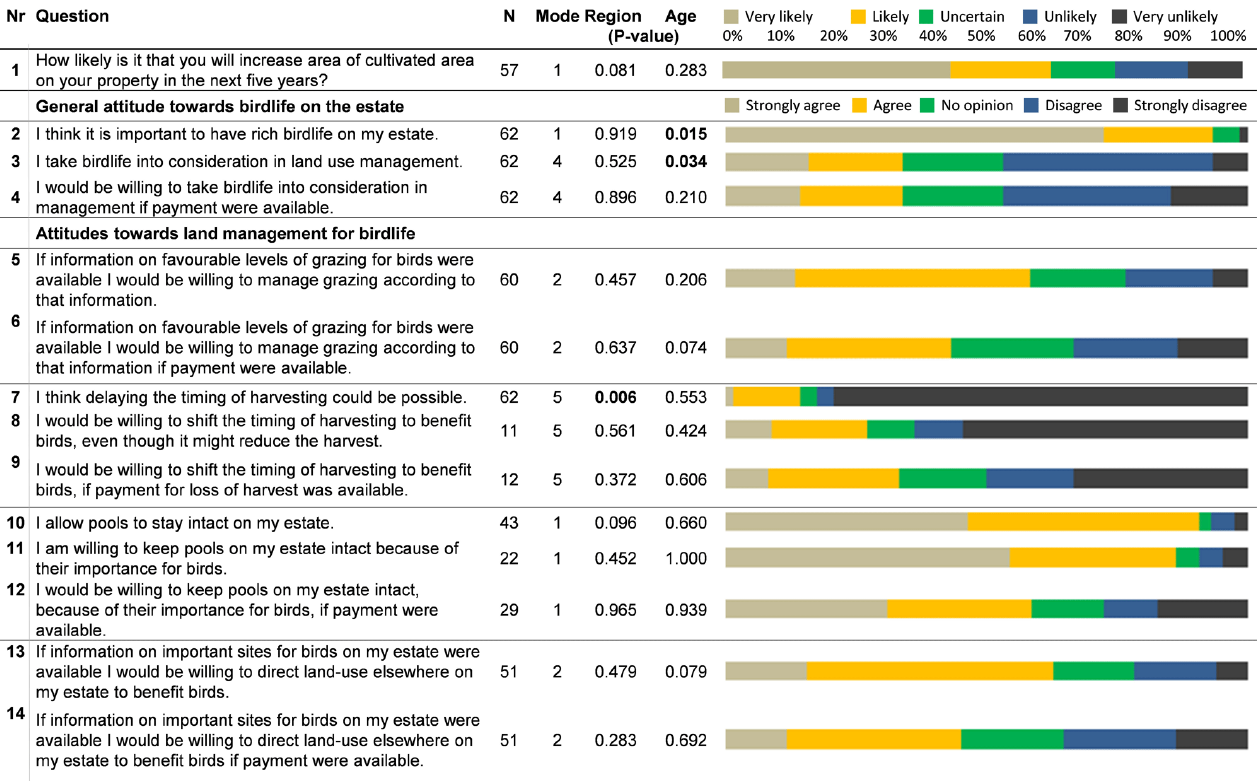
Fig. 4 . The number of farmers responding to each question, their modal (most frequent) response (the mode number refers to the answers going from left to right: 1 = very likely/strongly agree to 5 = very unlikely/strongly disagree, and the percentage of respondents selecting each of the five possible responses), and the results of Fisher’s exact tests of independence of differences in responses to each question between age groups (older or younger than median age) and regions (South, West, and North).